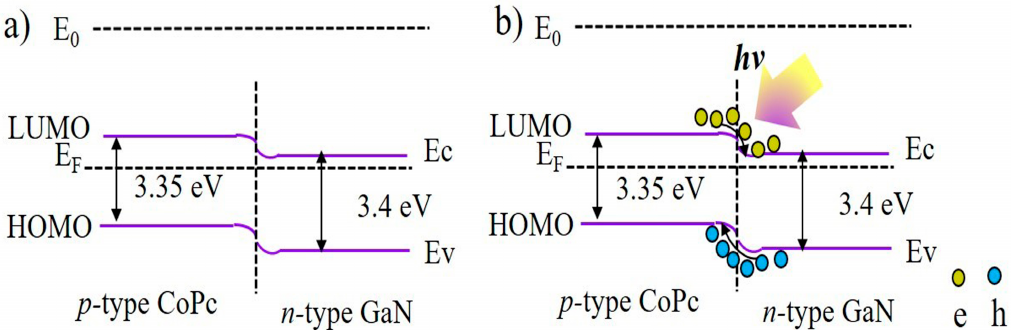
Figure 6. Band gap diagram of CoPc/porous-GaN p-n heterojunction UV PD under ( a ) the dark condition and ( b ) illumination condition.